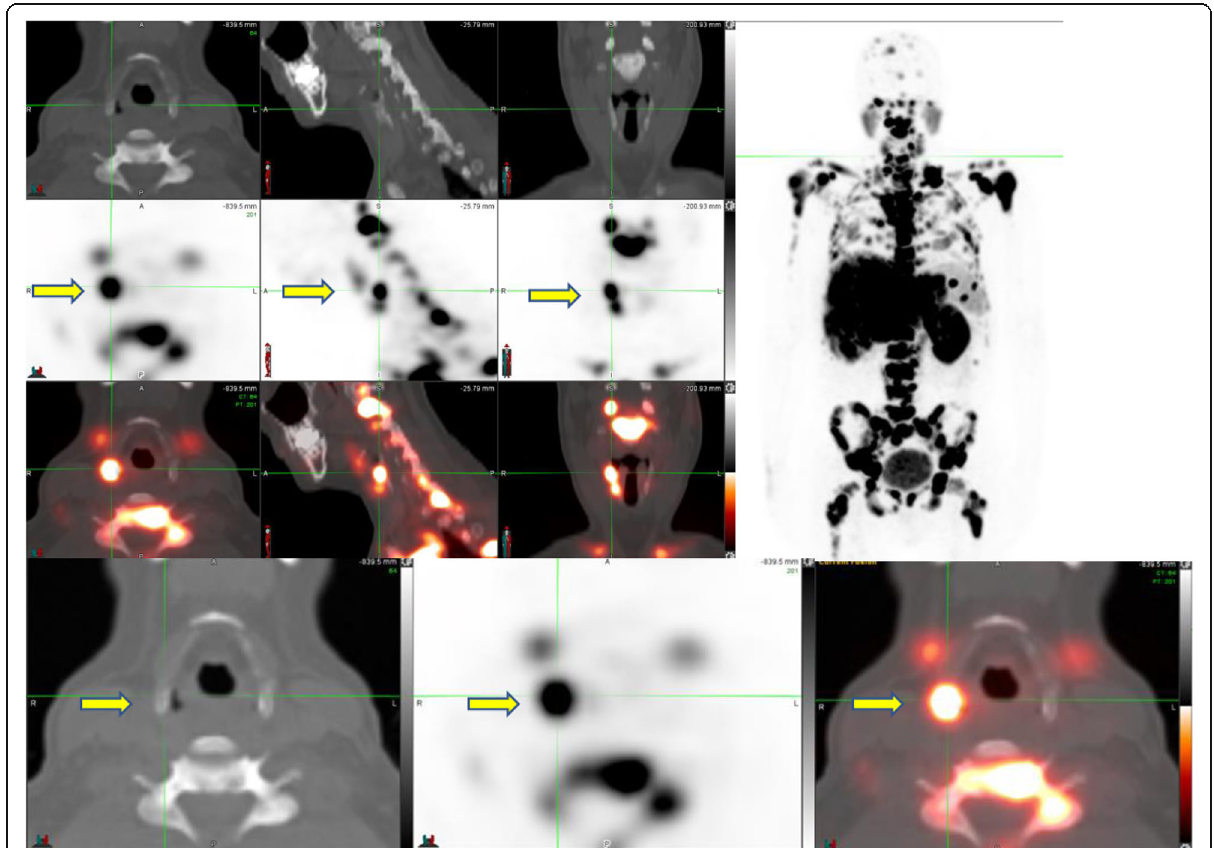
Fig. 1 68 Ga-PSMA-11 PET/CT scan images (CT image above, PET image in the middle, and fused images below) of a 55-year-old man with castrate-resistant metastatic prostate cancer. The PSA at the time of the PET/CT scan was 1000 ng/ml. The axial, sagittal, and coronal images of the neck show a very avid lesion (SUV = 12) in the right side of the thyroid cartilage (arrows). The maximum intensity projection (MIP)